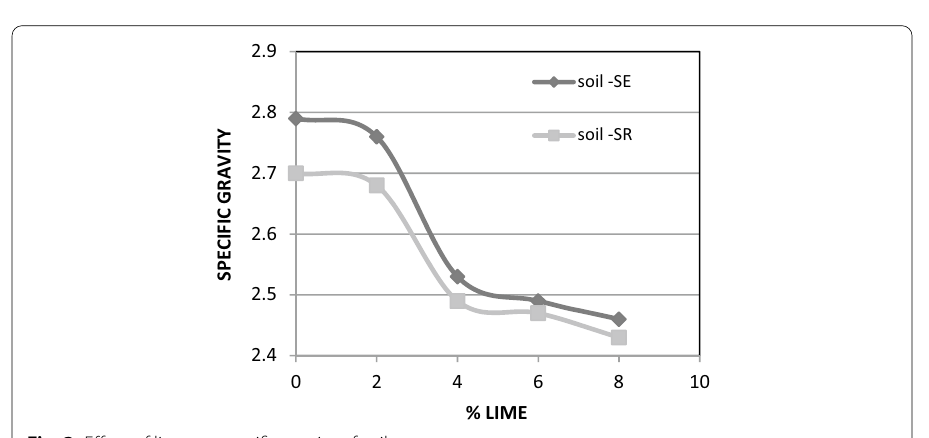
Fig. 3 Effect of lime on specific gravity of